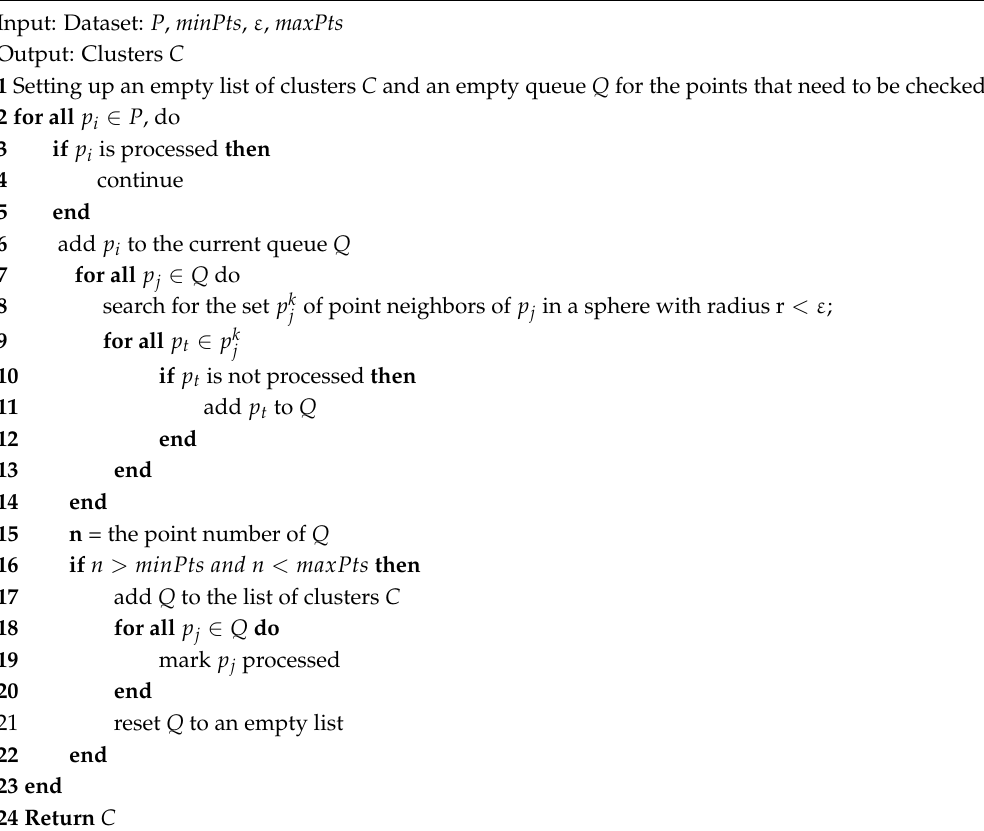
Algorithm 1 Improved DBSCAN